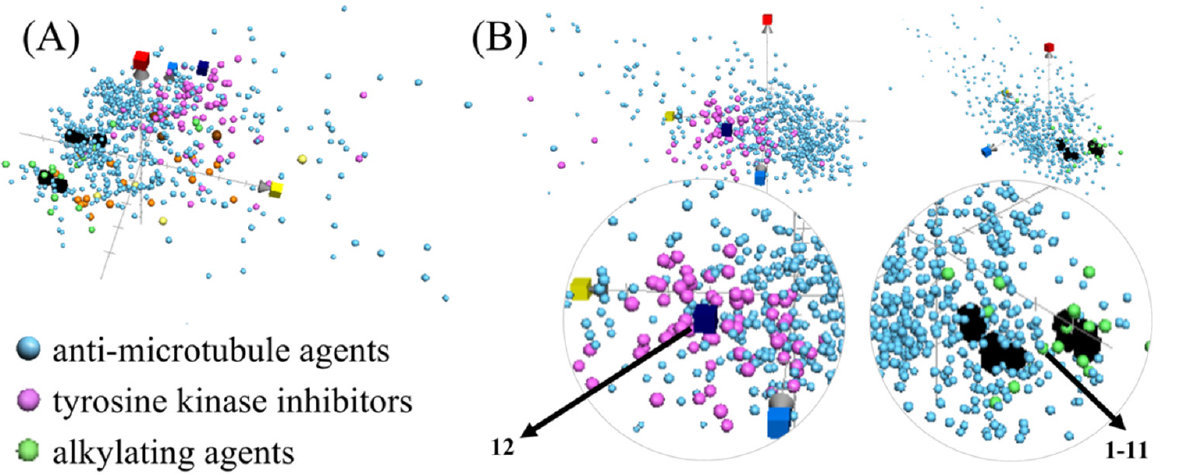
Figure 4. The plotted mode of action-relevant chemical patterns of the isolated compounds (DKPs 1 – 11 (black), and 12 (dark blue)), and the clinical chemotherapeutic agents searched from the ChEMBL database (alkylating agents (green, 19 compounds), anti-metabolites (orange, 21 compounds), proteasome inhibitors (yellow, 4 compounds), tyrosine kinase inhibitors (pink, 74 com- pounds), topoisomerase inhibitors (brown, 3 compounds), and anti-microtubule agents (light blue, 642 compounds)). The score plot was marked with three dimensions (principal components) includ- ing PC1 (red) describing the size, shape, and polarizability; PC2 (blue) representing the aromatic- and conjugation-related properties; and PC3 (yellow) depicting lipophilicity, polarity, and H-bond capacity. The overall view ( A ) and the individual views ( B ) of the analytical results.